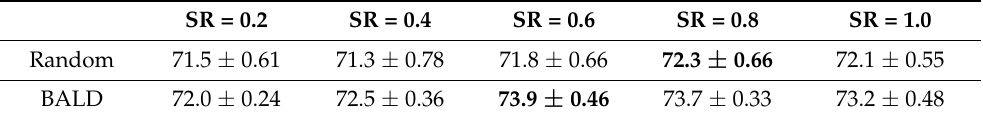
Table 1. The performances under different settings in the sample assessment test. (Benchmark NN architecture: ResNet-32, training dataset: CIFAR-10, SR: sample